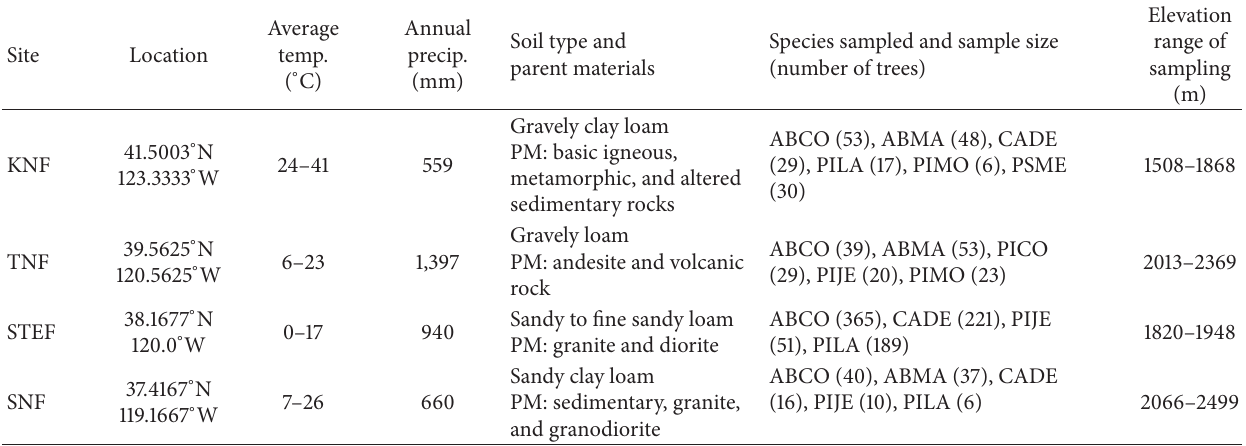
Table1:DescriptionofstudysitesatKlamathNationalForest(KNF),TahoeNationalForest(TNF),Stanislaus-TuolumneExperimentalForest (STEF), and Sequoia National Forest (SNF). Average temperature is reported as the mean temperature during winter and summer months, respectively. Soil types include parent material (PM). Species sampled: Douglas-fir (PSME), red fir (ABMA), white fir (ABCO), incense-cedar (CADE), sugar pine (PILA), western white pine (PIMO), Jeffrey pine (PIJE), and lodgepole pine